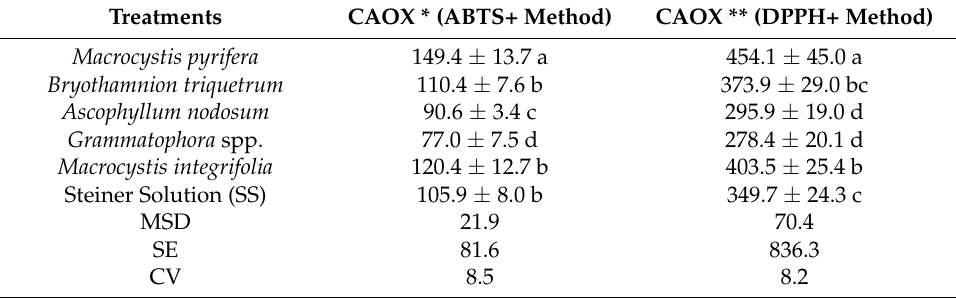
Table 4. Antioxidant capacity of cucumber produced in shade mesh with the application of different nutrient solutions derived from algae, using two methods (ABTS+ and DPPH+).